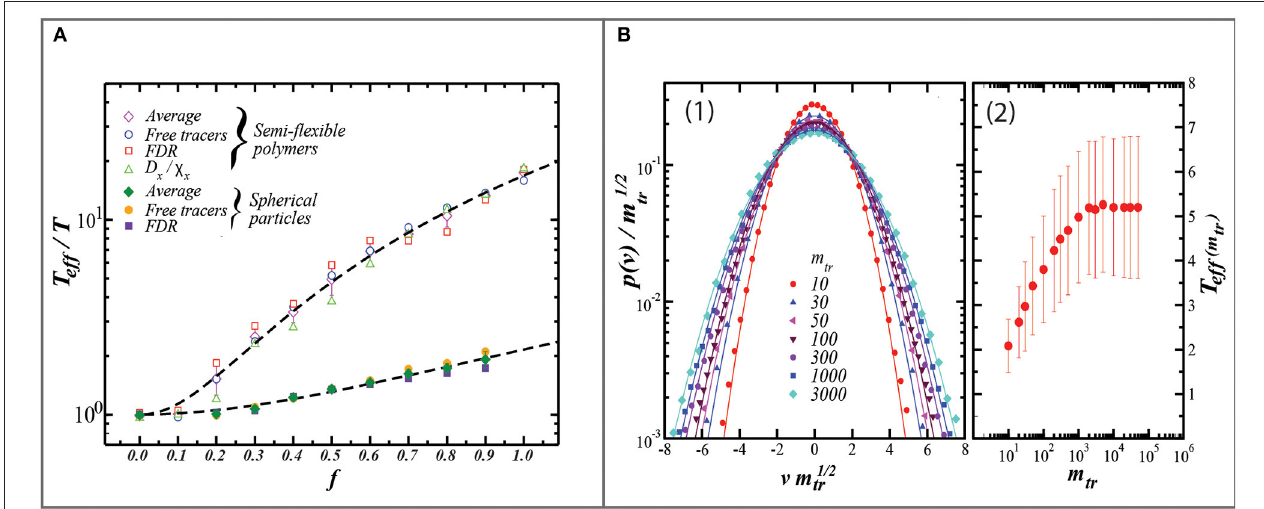
FIGURE 3 | Two figures from Loi et al. (2011b). (A) Relationship between the recovered value of T ∗ (i.e., T eff ) relative to the bath temperature ( T ) vs. the dimensionless driving strength ( f ) from two model configurations: one comprised of flexible polymers of 21 units long, the other of hard spheres. Values which are plotted are the average of T eff / T derived from motorized tracers (diamonds), from free tracers (circles), the fluctuation-dissipation ratio (squares), and in the case of the semi-flexible polymers, the ratio of the diffusion coefficient ( D x ) to the susceptibility ( X x ). Importantly, this figure highlights that the internal degrees of freedom (i.e., flexible vs. hard sphere) have the potential to differentially affect the value of T ∗ which is retrieved for a given driving rate. In the context of soils, this figure provides evidence that the temperature sensitivity of soil dynamics (akin to a heat capacity), depend on the soil properties (such as texture) which affect the internal degrees of freedom of the soil (B) : (1) Graph of the probability distribution of the velocity ( p ( v )) plotted vs. the scaled velocity ( vm 1 / 2 ), where v is the velocity and m is the mass of the tracer. (2) The effective temperature of the tracer particle as extracted from the velocity data and plotted as a function of tracer mass. The model predicts that the variance and absolute value of T ∗ increases with increasing tracer mass, eventually saturating at 50x the mass of the 21-unit polymer. These modeling results suggest that within soil, less massive tracers are more prone to self-diffusion and therefore underestimate the long-term stirring rates and the effective temperature. Both figures reprinted from Loi et al. (2011b), courtesy of the Royal Society of